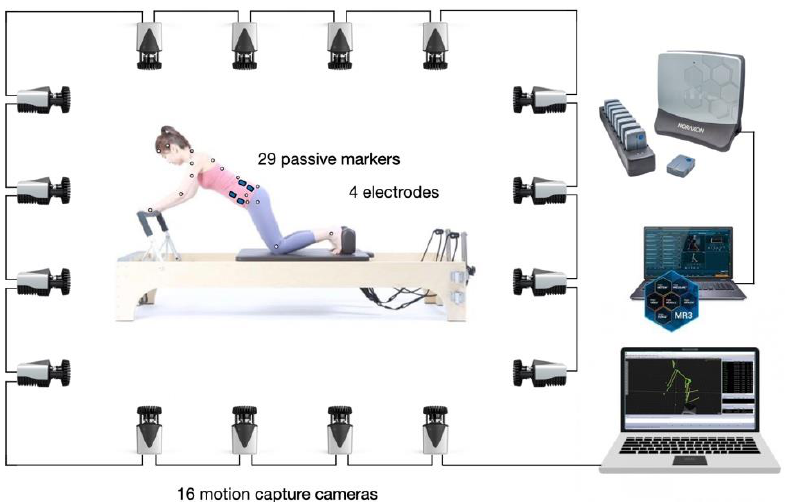
Figure 2. The diagram of 3D motion capture system and electromyography for kinematic